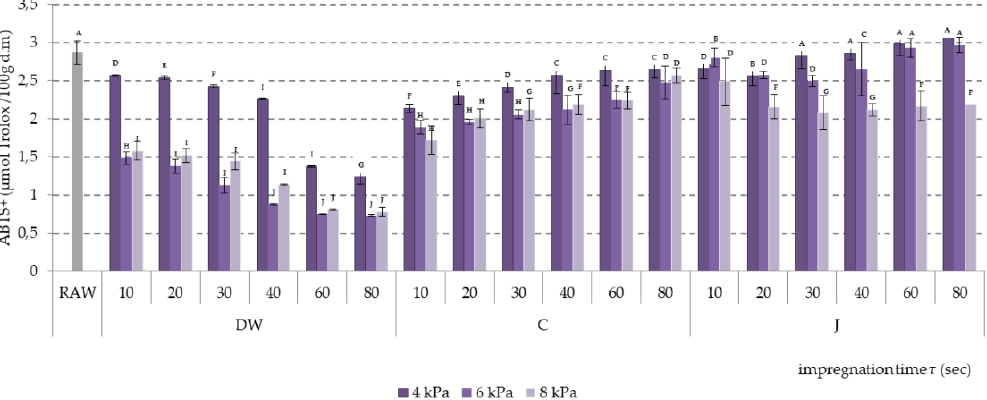
Figure 5. ABTS + antioxidant activity of apples impregnated using vacuum pressures of 4, 6, and 8 kPa and apple-pear juice (J), citric acid solution (C), and distilled water (DW) as impregnating liquids. Values followed by different letters (A, B, C…) were significantly different ( p < 0.05) according to Tukey’s test.